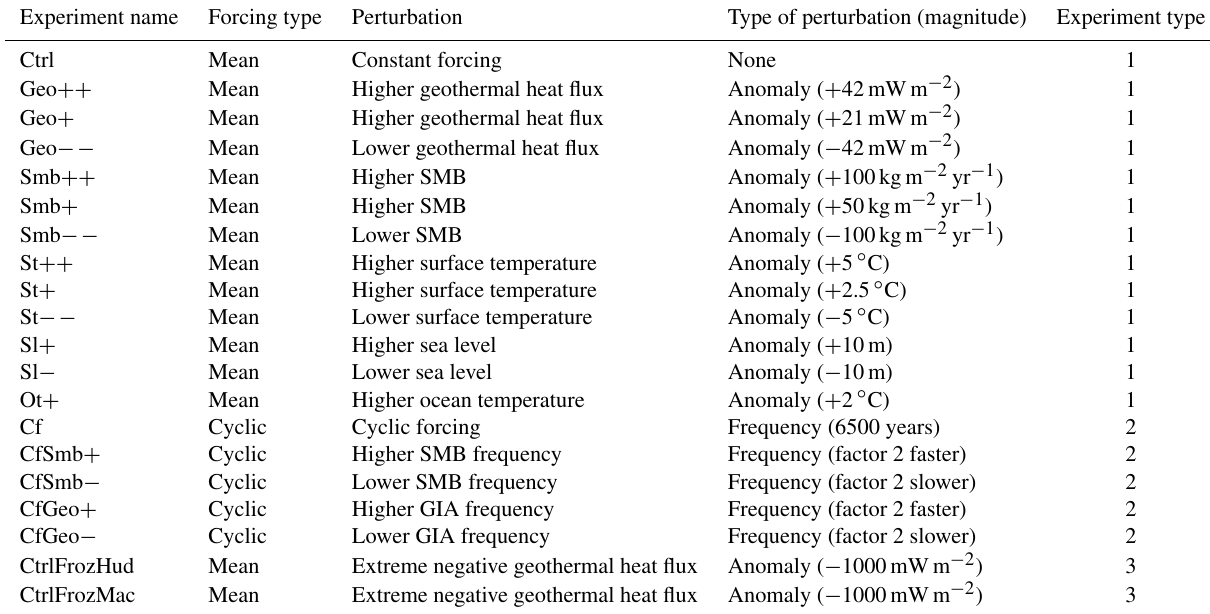
Table 1. List of all perturbation experiments including type and magnitude of forcing. Abbreviations stand for control (Ctrl), geothermal (Froz), Hudson (Hud), and Mackenzie (Mac). The − and + signs represent negative and positive perturbations. Experiment type refers